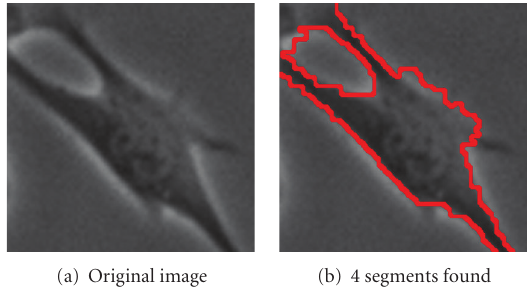
Figure 8: Parameters used: (b) n = 60, α = 130, (cid:7) α = 5, β = 50, θ = 0 . 08, γ = 0 . 5, d 1 = 0 . 15, σ = 6, ρ = 1.